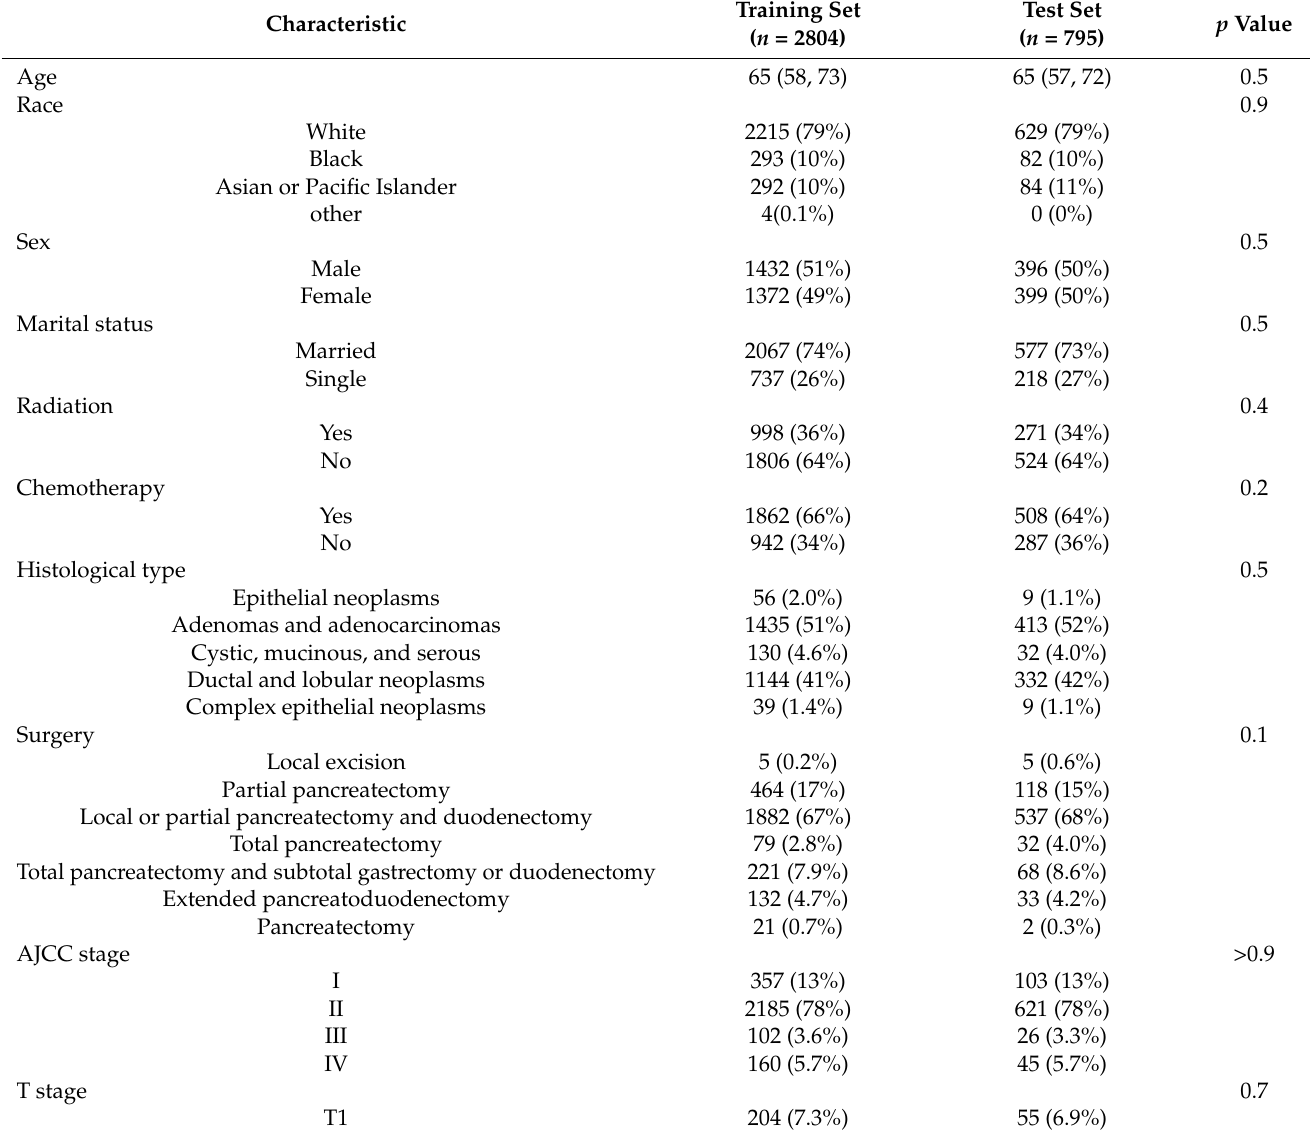
Table 1. The information for postoperative pancreatic cancer patients in the training set and the test set.